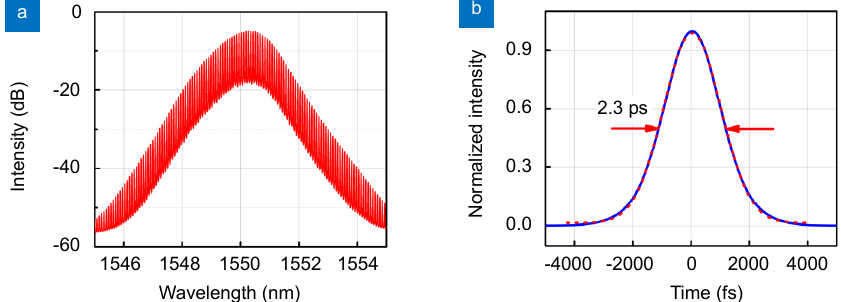
Fig. 1 | The 10 GHz OFC and a 2.3-ps pulse generated from a mode-locked laser with (a) OFC spectrum, and (b) reconstructed temporal pulse profile (blue solid curve) and Gaussian fitting curve (red dotted